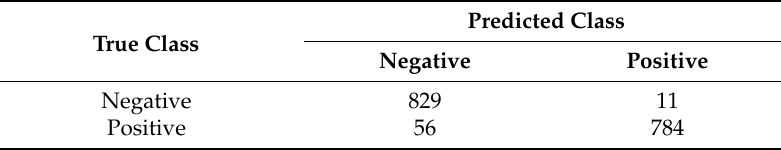
Table 12. Deep FC2 features and LR classifier.